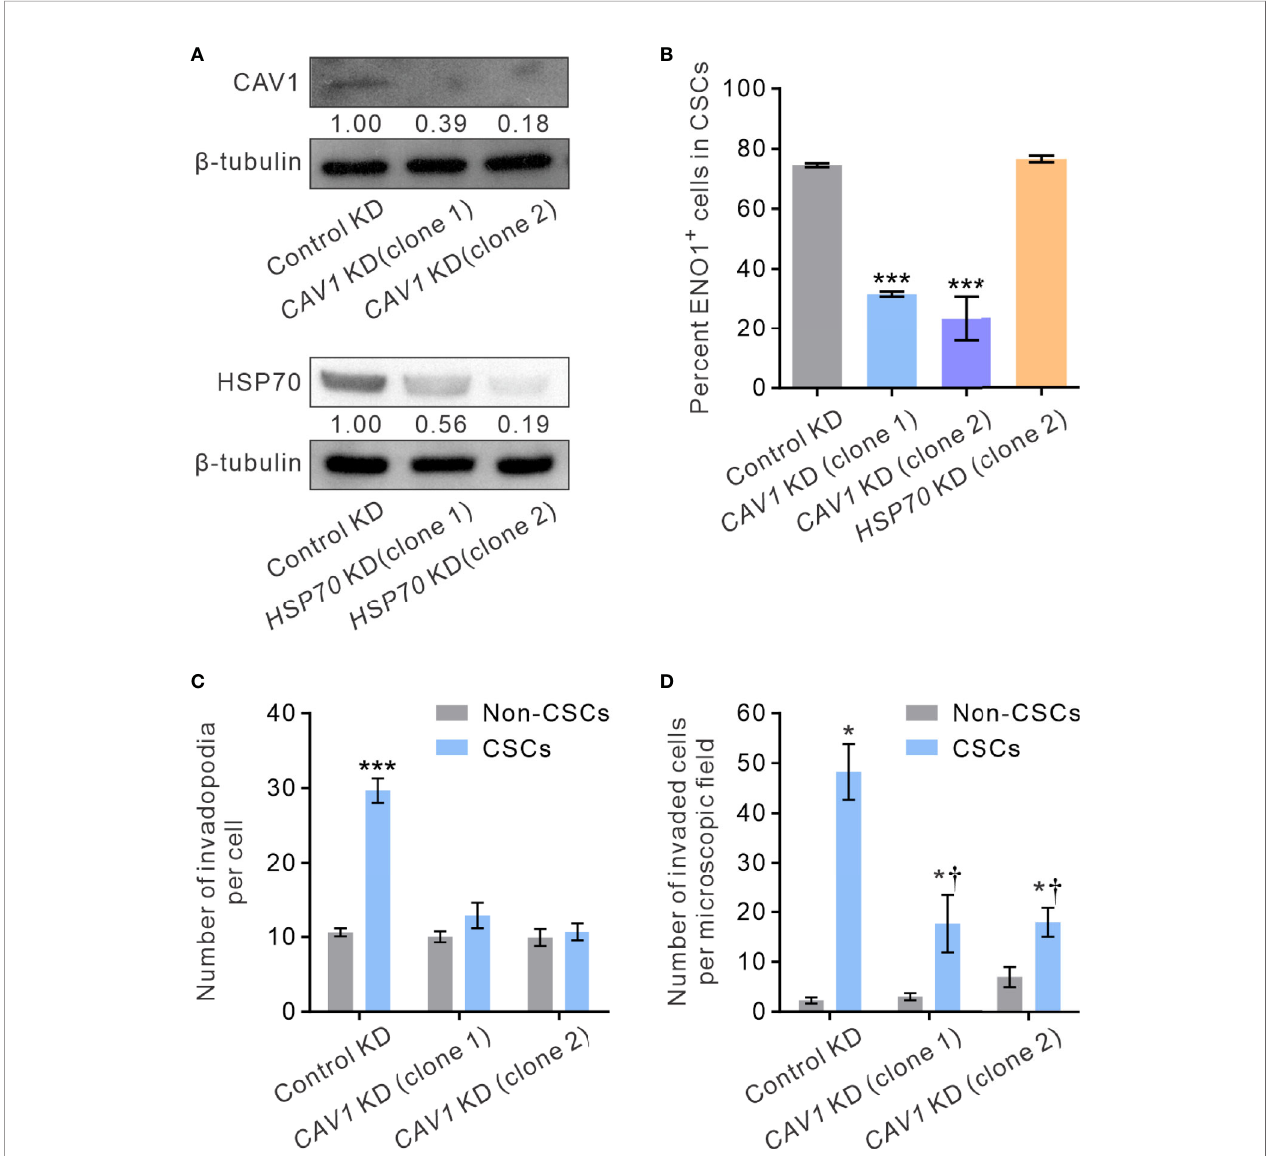
FIGURE 7 | CAV1 is indispensable for the surface localization of sENO1 on CSCs and its pro-invadopodia and pro-invasive functions. (A) Immunoblotting analysis showing the effect of lentivirus shRNA-mediated knockdown (KD) of CAV1 (top) or HSP70 (bottom) expression in PC-3 cells. Protein levels were quanti fi ed by densitometric analysis of the bands, normalized to b -tubulin (loading control). (B) Bar graph showing the percentage of sENO1 + cells in PC-3 CSCs (represented by CD44 + CD33 + cells) with KD of CAV1 or HSP70 expression or control-KD. Unpaired t-test was performed throughout where ***p < 0.001 versus control KD. (C) Bar graph showing the density of invadopodia (represented by coractin + F-actin + puncta) per cell in PC-3 CSCs or non-CSCs (represented by cells in other subpopulations) with CAV1 KD or control KD. Unpaired t-test was performed throughout where ***p < 0.001. (D) Bar graph showing the invasive capacity of PC-3 CSCs or non-CSCs with CAV1 KD or control KD in a dual-chamber invasion assay. Error bars represent mean ± SEM from three independent experiments (n = 3). Unpaired t-test was performed throughout where *p < 0.05 versus non-CSCs; † p < 0.05 versus control